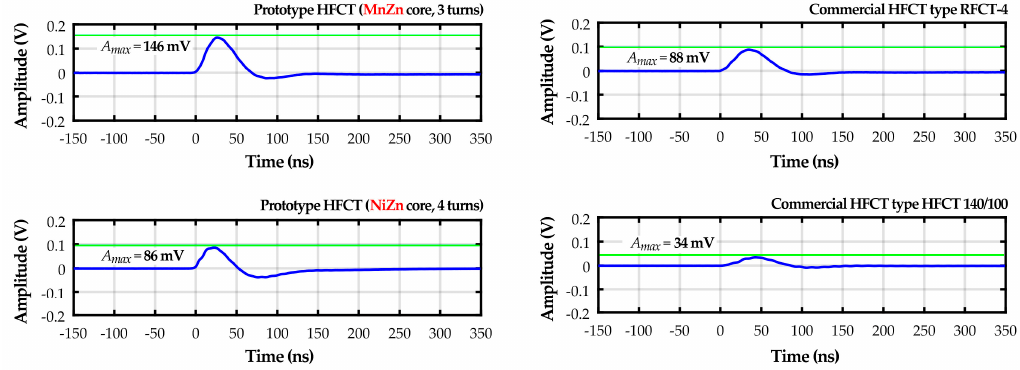
Figure 17. Impulse response of the prototype (MnZn ferrite core with three turns, NiZn ferrite core with four turns) and commercial HFCT sensors to partial discharge calibration impulse with an apparent charge of 500 pC.